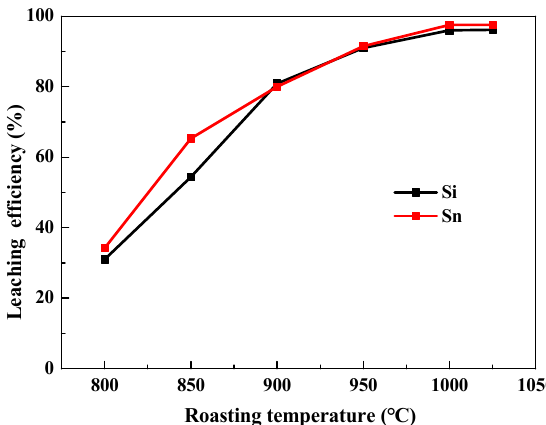
Figure 1. Effect of roasting temperature on leaching efficiency of Sn and Si (Time: 60 min).